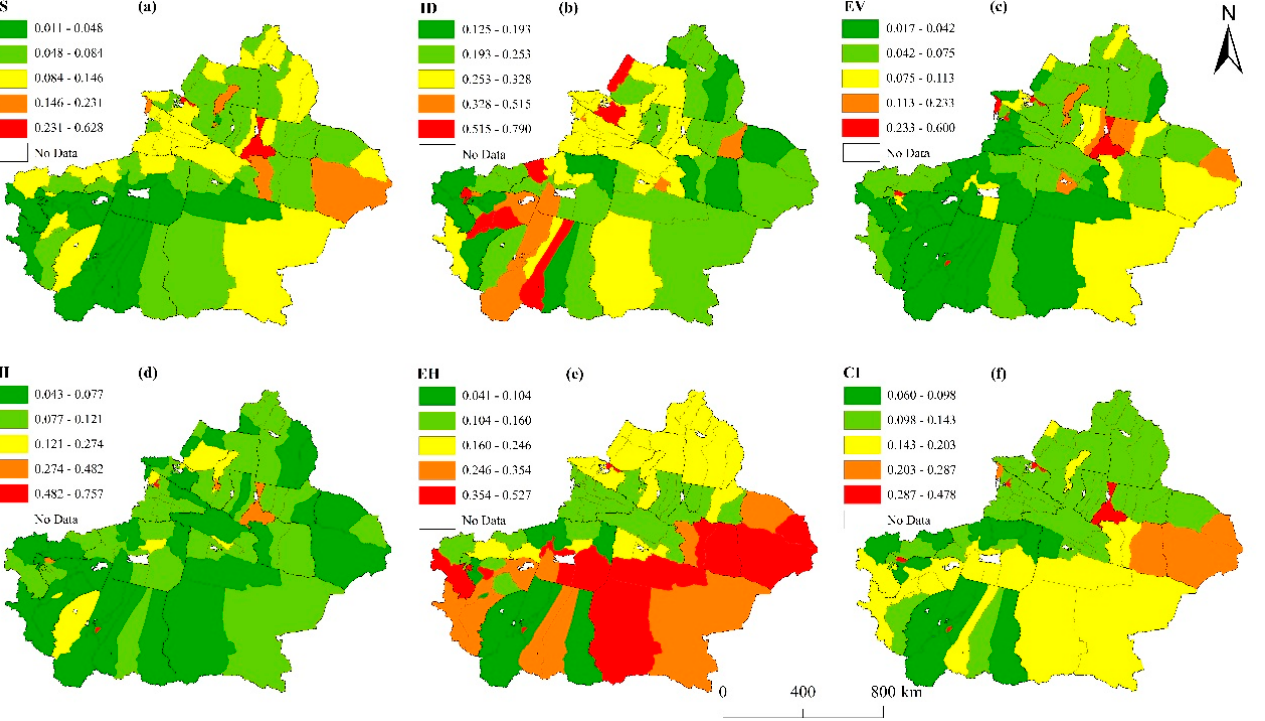
Figure 6. Illustration of the spatial distribution of the dimensional and comprehensive indices for each county (city). Note: Figures ( a – f ) represent the grading diagram of the evaluation results from five dimensions of Safety and Stability, Social Integration, Economic Vitality, Happiness and Livability, Ecological Health, respectively.